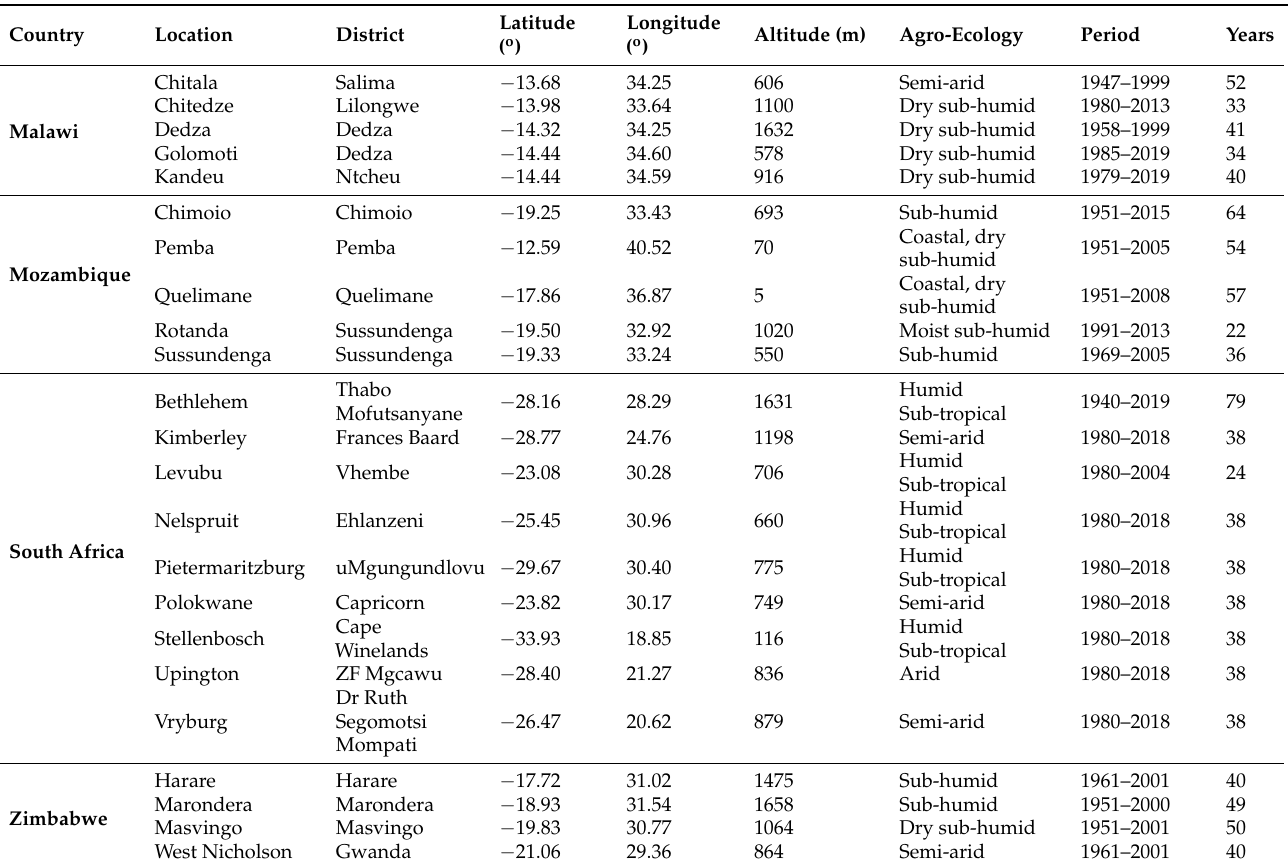
Table 1. Location-related information of the meteorological stations and time period of the tempera- ture data sets used in the study in the four southern African